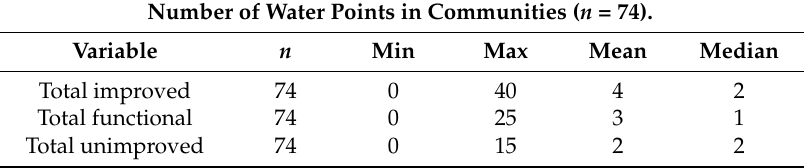
Table 2. Number of water points in communities. Number of Water Points in Communities ( n = 74).